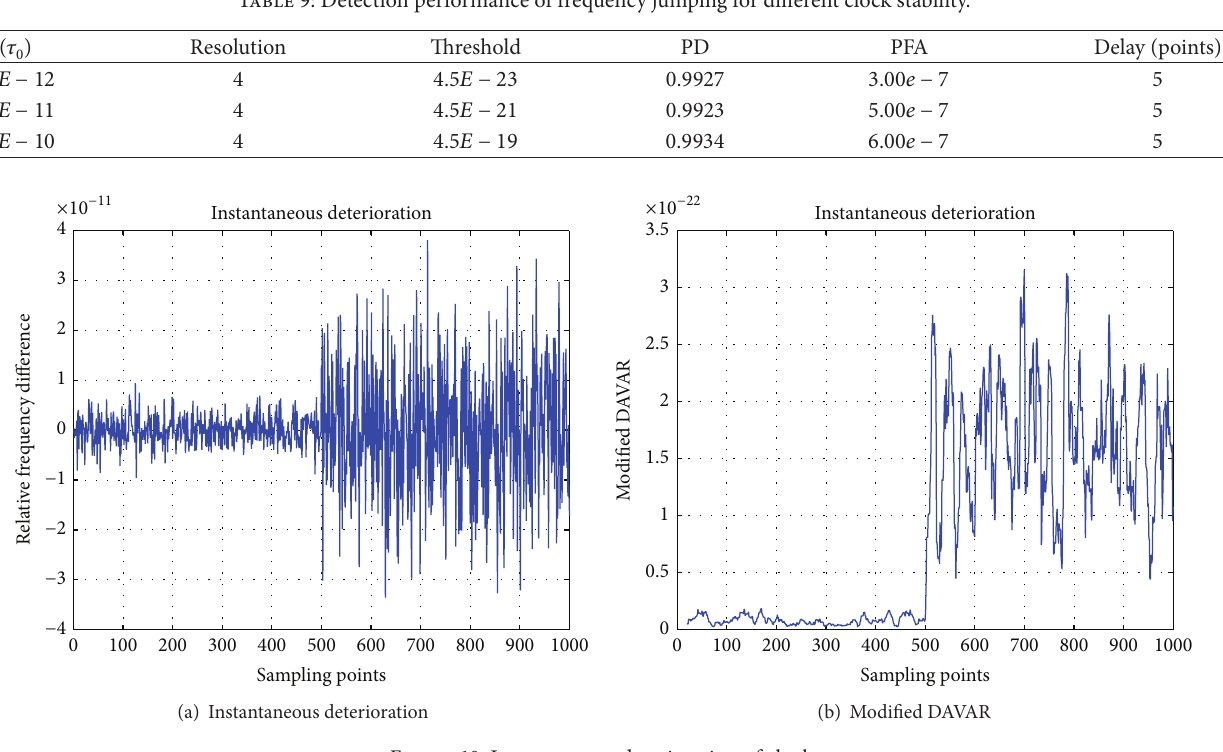
Figure 10: Instantaneous deterioration of